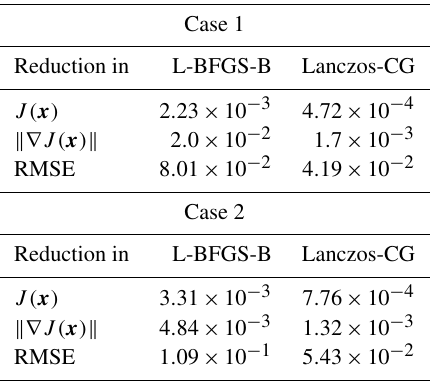
Table 5. Summary of inverse modeling experiment results. The re- ductions of cost function J( x ) , gradient norm (cid:107)∇ J( x ) (cid:107) , and RMSE are given as the ratio to their respective starting values. Results of the two experiment cases are the values after 70